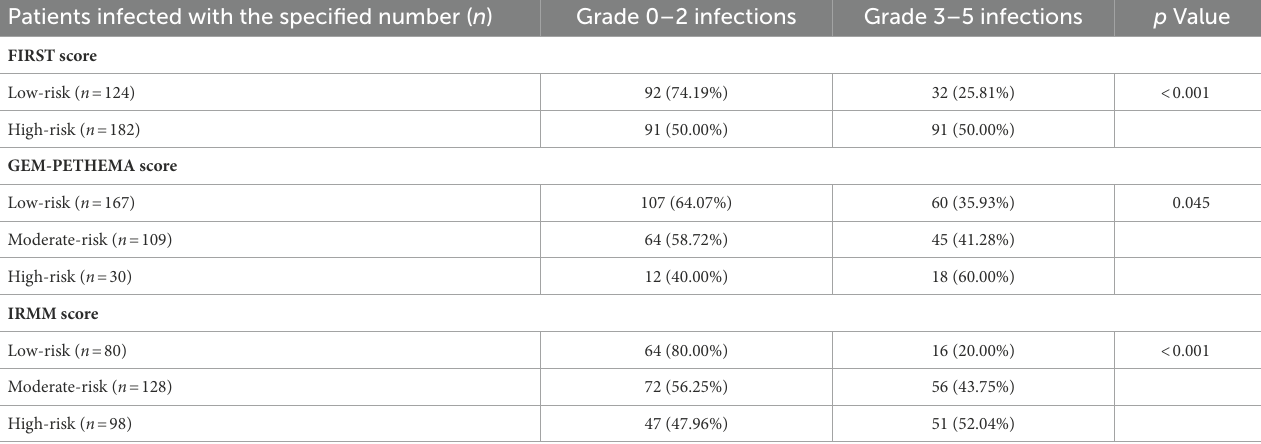
TABLE 2 Grouping and infection of the FIRST score, GEM-PETHEMA score and IRMM score. Patients infected with the specified number ( n